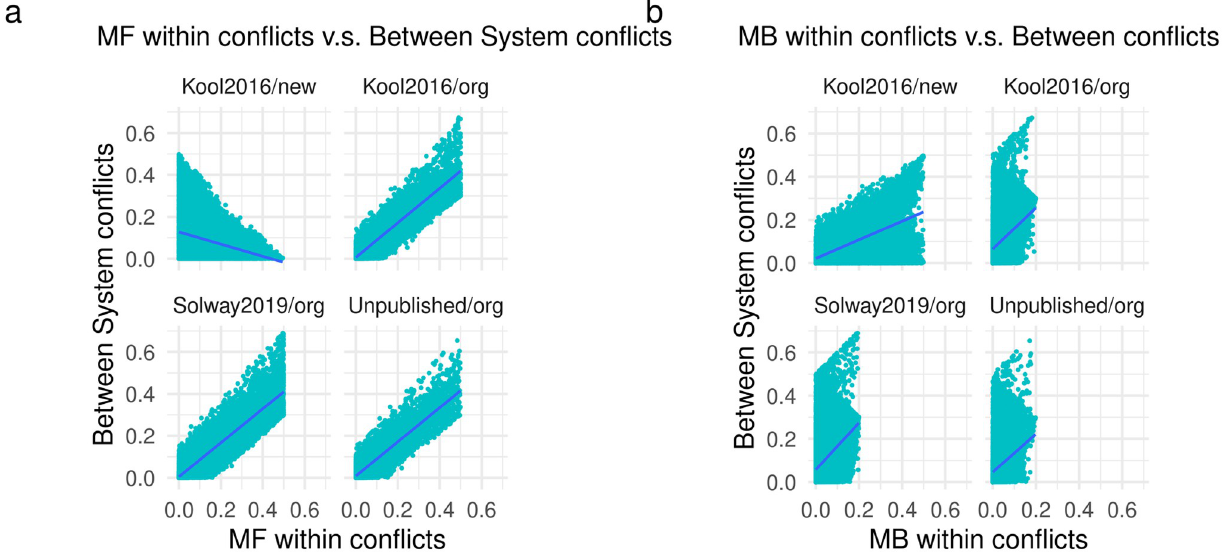
Fig 5. A. Model-free within-system value conflict versus between-system value conflict across all participants and trials for each dataset. B. Model-based within-system value conflict versus between-system value conflict.